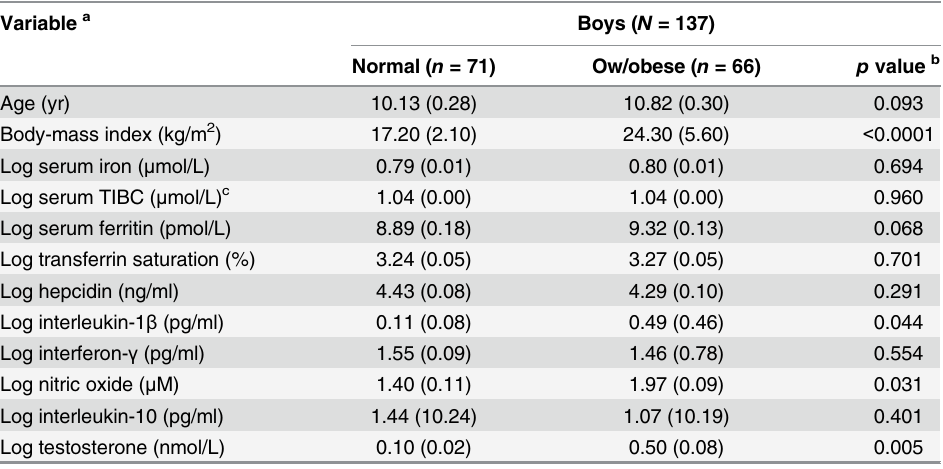
Table 2. Clinical and biochemical data according to the nutritional status ( N =